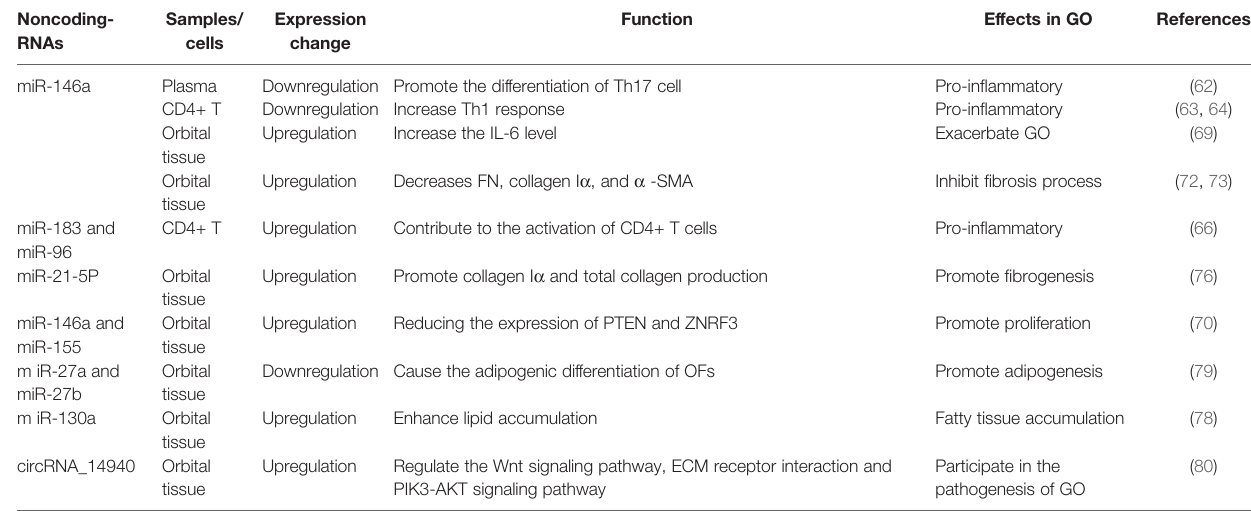
TABLE 1 | Non-coding RNAs in the pathogenesis of GO. Noncoding-